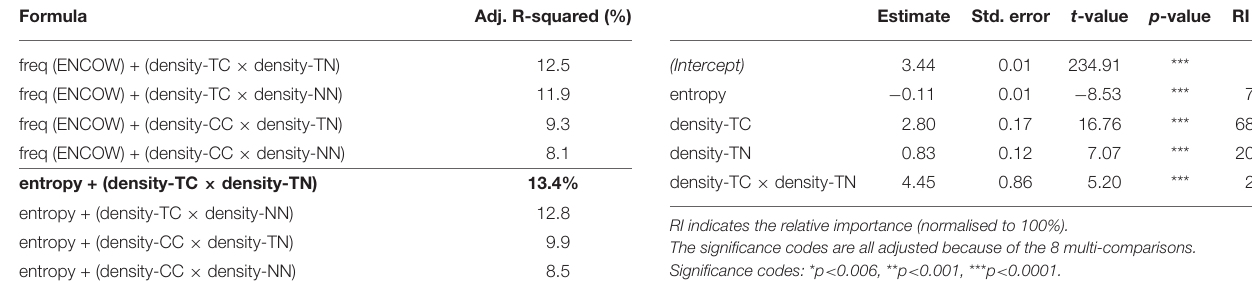
TABLE 3 | Comparison of model variants processing noun targets in the N-V-A space, and their explained variance (represented in terms of adjusted R-squared). Formula Adj. R-squared (%)